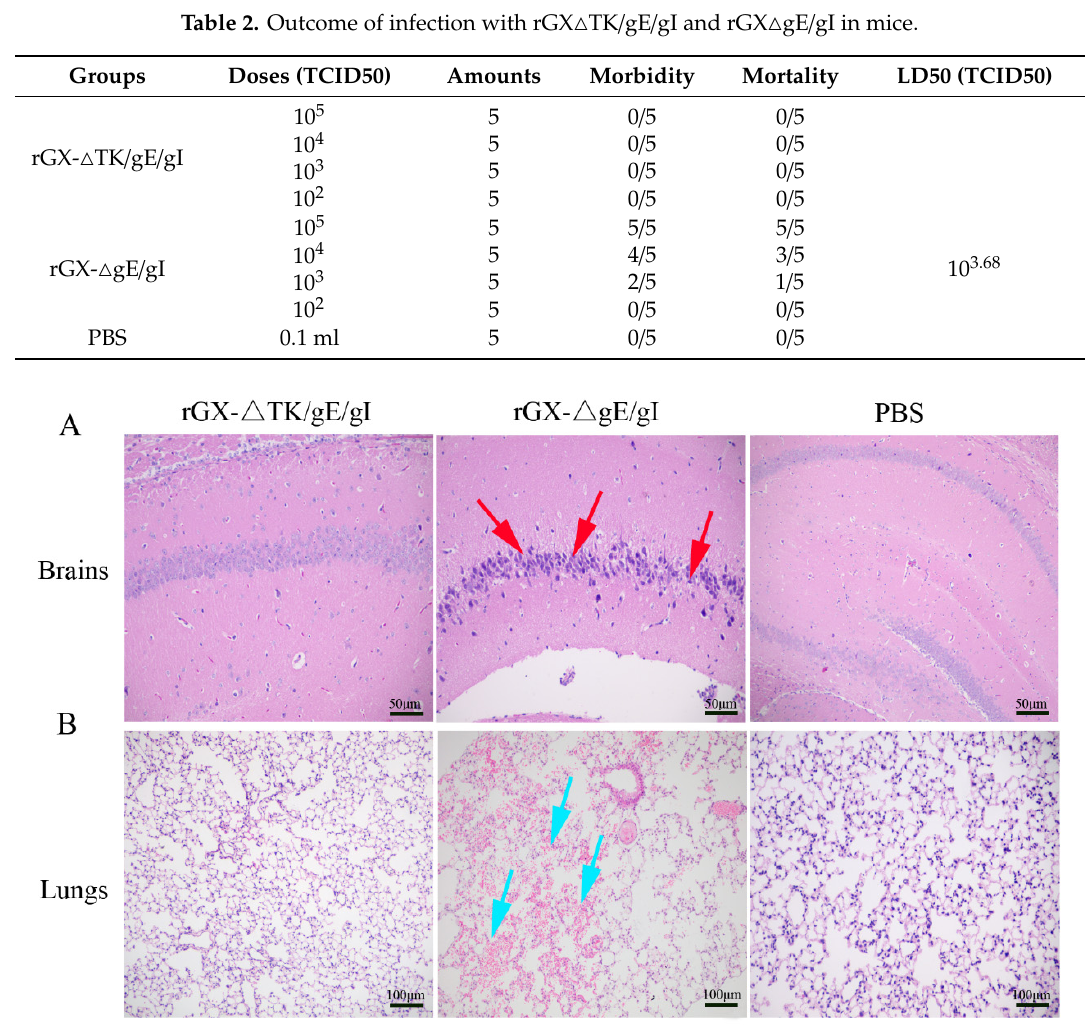
Figure 3 . The effect of the gE/gI- and gE/gI/TK-gene-deleted PRVs on histopathological lesions in mice. ( A , B ) Pathological lesions of brain and lung tissues were detected using HE staining. Scale bar, 50 or 100 µ m. Arrows indicate the cell infiltrates. HE, hematoxylin and eosin staining.